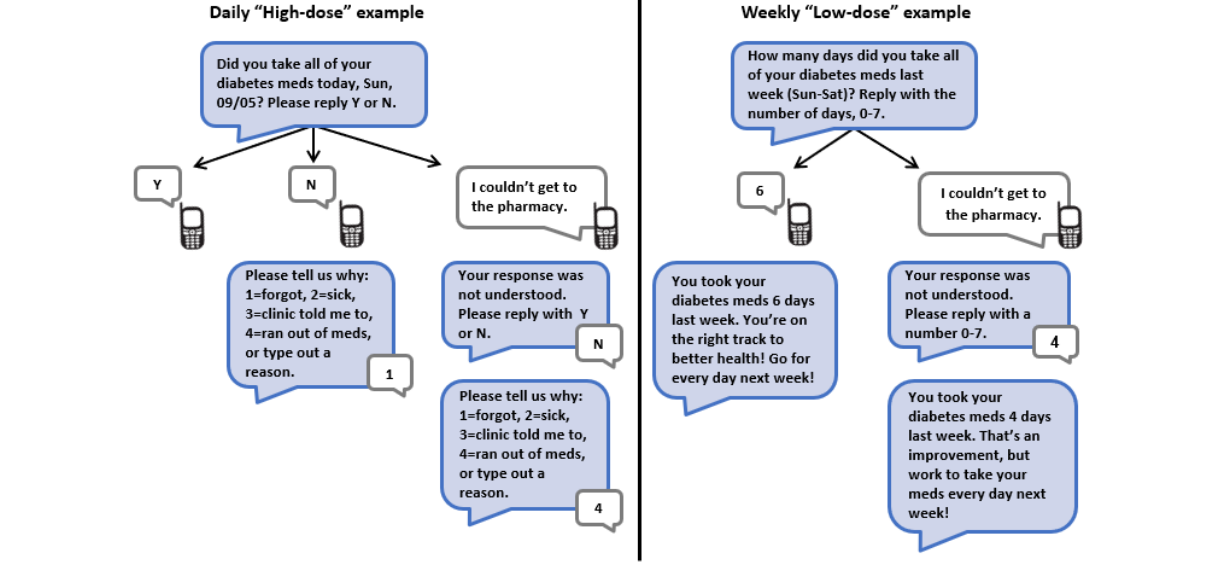
Figure 2. Comparison of functionality for the interactive text message based on whether it was sent daily (high-dose) or weekly (low-dose). Blue messages are intervention texts, and white messages are examples of participant